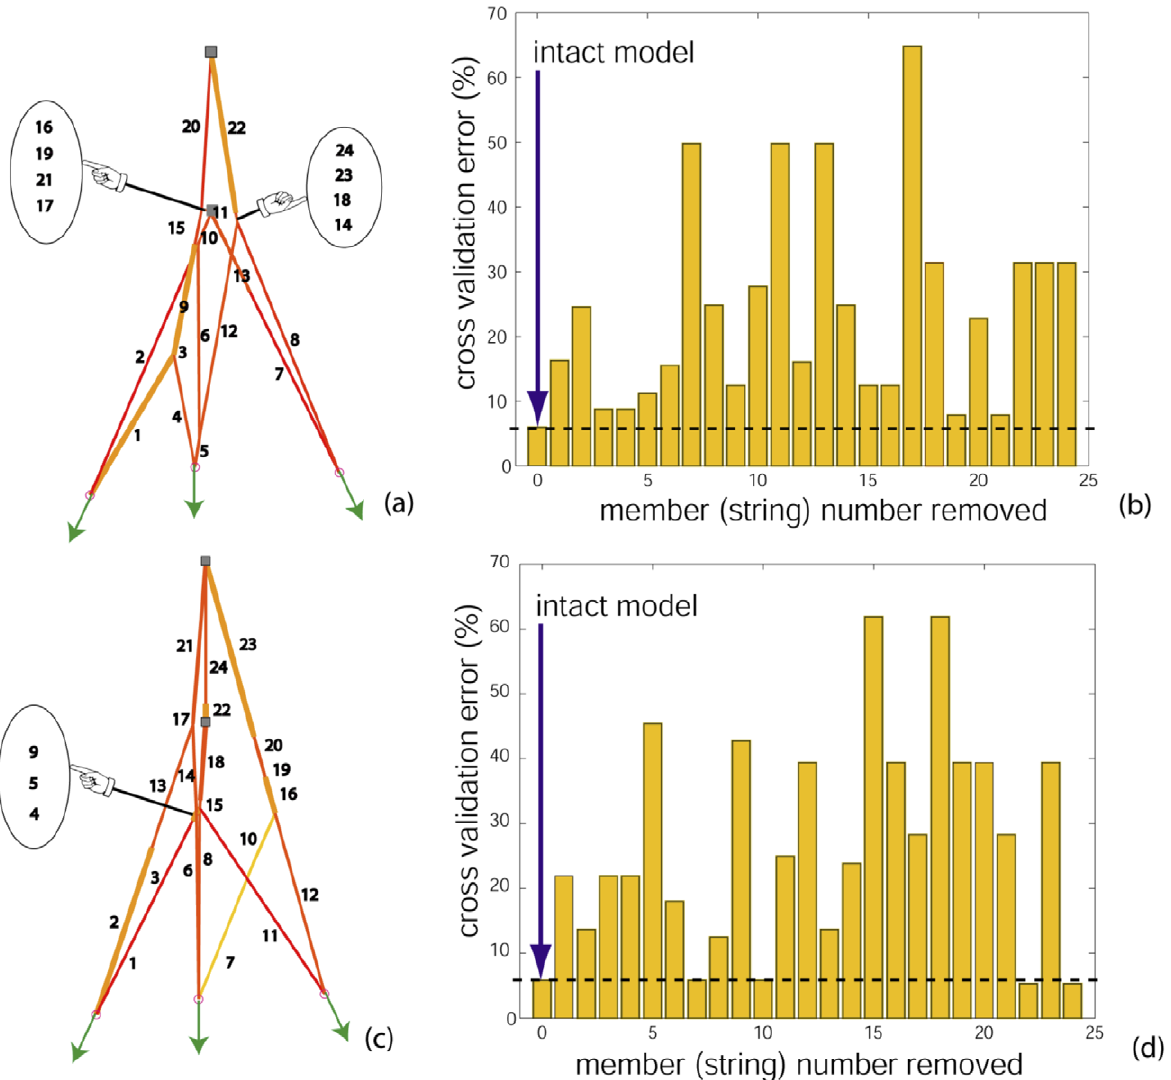
Figure 7. Individual strings contribute significantly to the functionality of the chosen models. (a) model (i) in Fig. 4e and (c) model (iv) in Fig. 4e with string members numbered. (b) Each string member is removed one at a time from model (i) and cross validation errors are computed. The intact model (with no string removed) exhibits the least cross validation error. (d) Each string member is removed one at a time from model (iv) and cross validation errors are computed. On removal of strings 22 or 24, the error decreases. This suggests that connection between middle and distal slips should be absent. Removing string 7 or 10 from the model in (c) does not alter the cross validation error from that of the intact model. This is because these strings do not get taut when cross validating load sets are used. Visual inspection further shows that these strings barely get taut when the model is actuated with the informative load sets used for its evolution. This suggests that strings 7 and 10 do not participate in the network which explains why the training set error for this model is larger (Table 2) compared to that of model (i) in